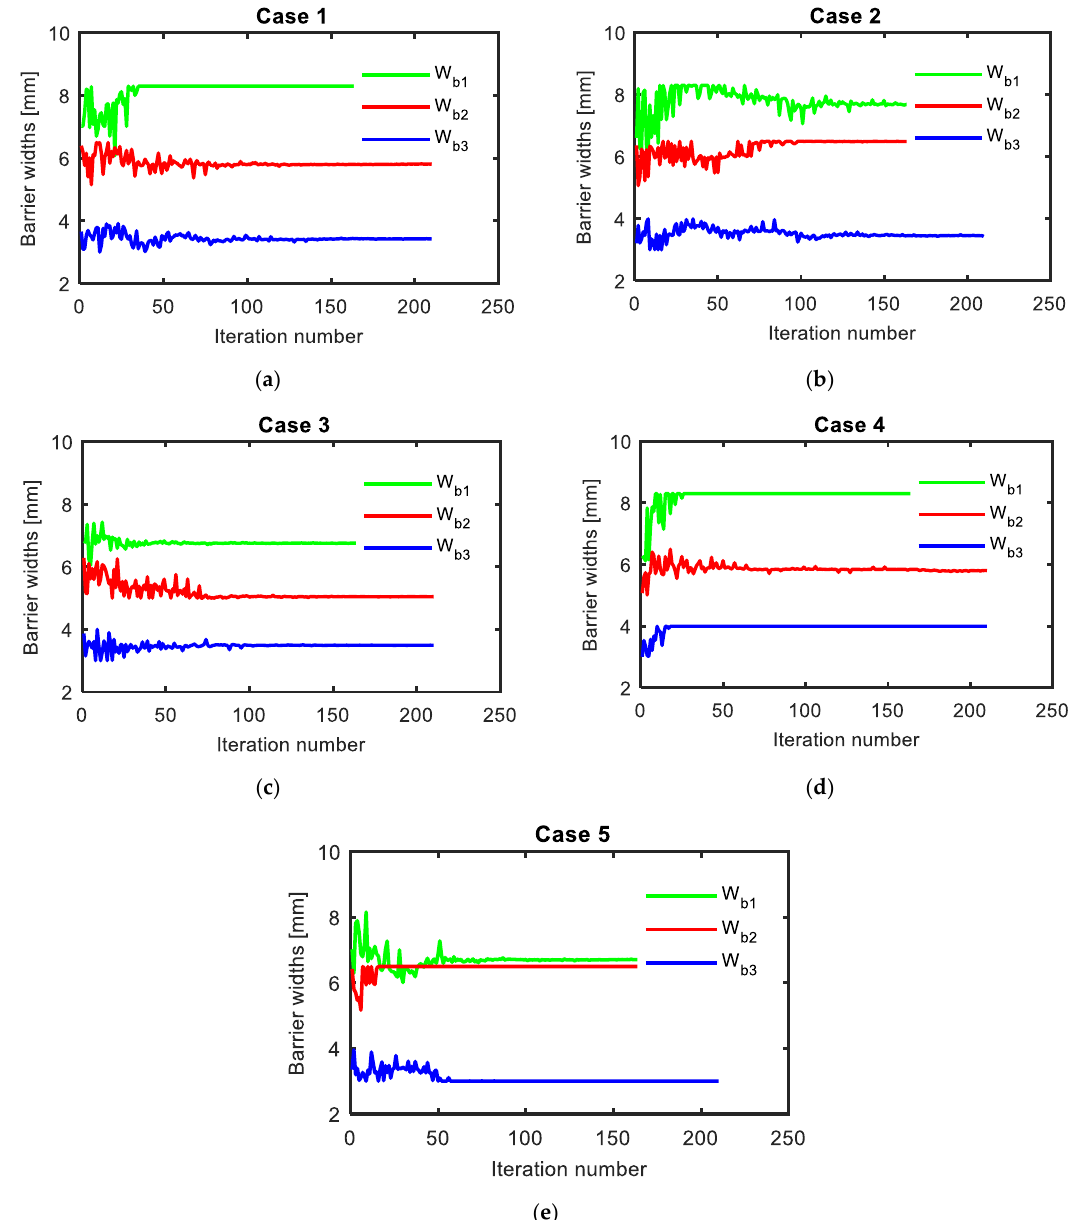
Figure 8. Optimal geometry of flux barrier widths for different cases, ( a ) case 1, ( b ) case 2, ( c ) case 3, ( d ) case 4 and case 5.